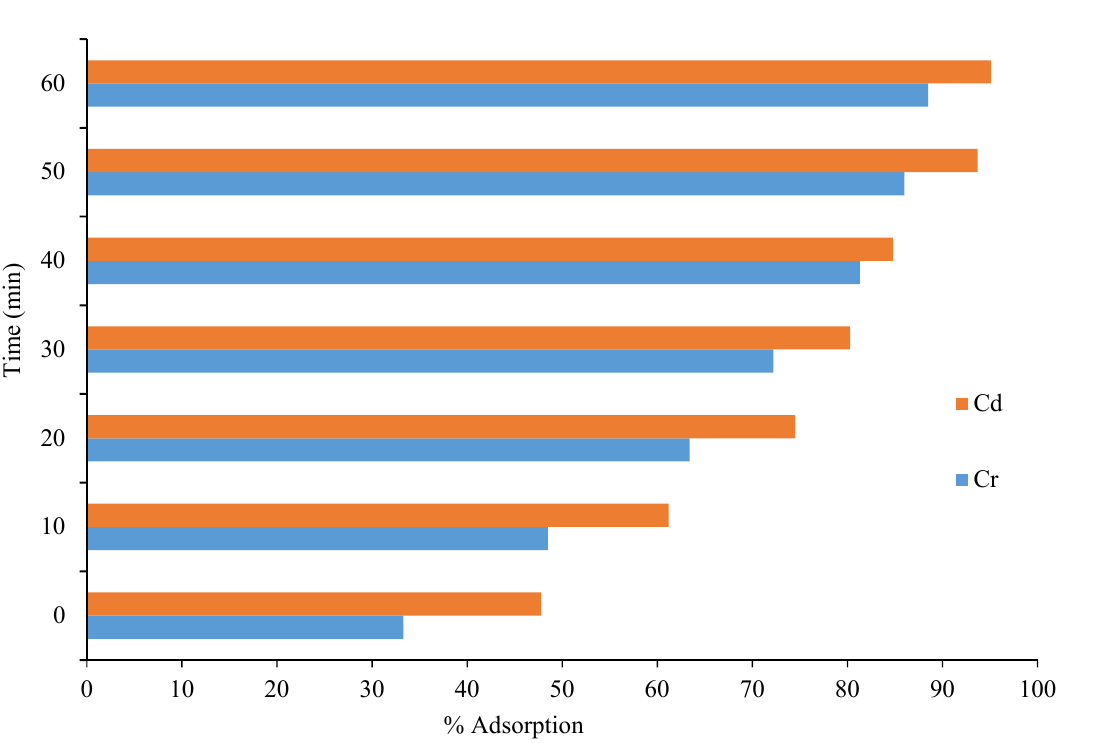
Figure 8. Removal (in percentage) of Cd and Cr using the CeO 2 /corncob nanocomposite as a function of time.